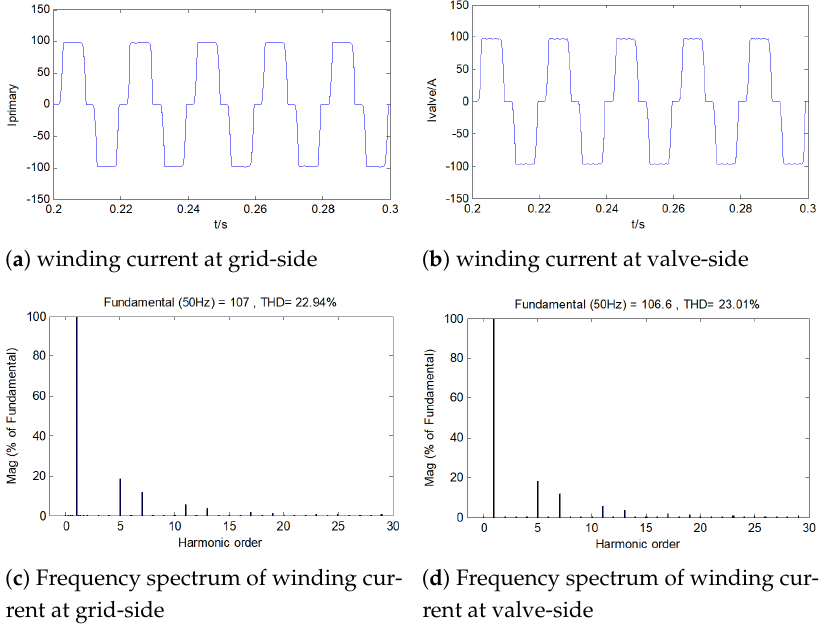
Figure 6. Waveform and frequency spectrum of winding current from the valve-side and grid-side on the left column of the converter transformer under working condition 1.